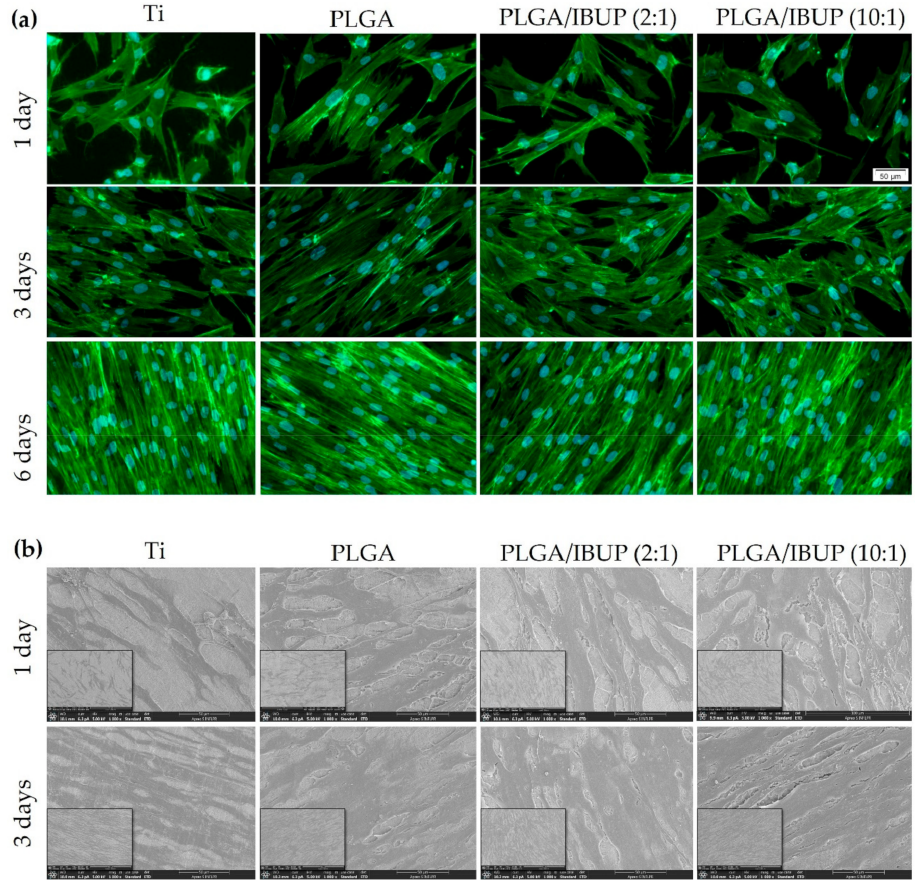
Figure 10. Morphological features of human fibroblasts on PLGA-based coatings, evidenced by: ( a ) fluorescence microscopy showing actin filaments (green) and nuclei (blue), scale bar 50 µ m; ( b ) SEM investigation, scale bar 50 µ